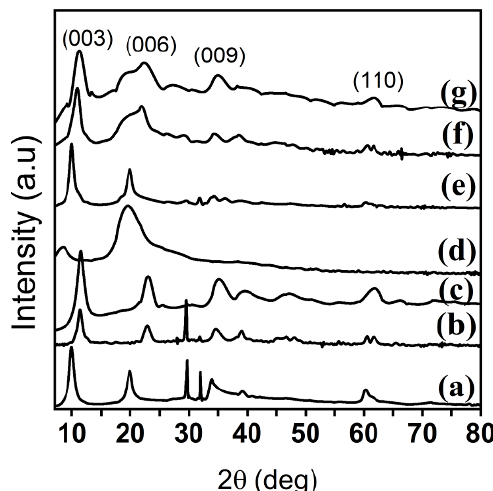
Figure 4. UV-Visible spectra of mixture MB, MG, and CR onto Zn/Al-